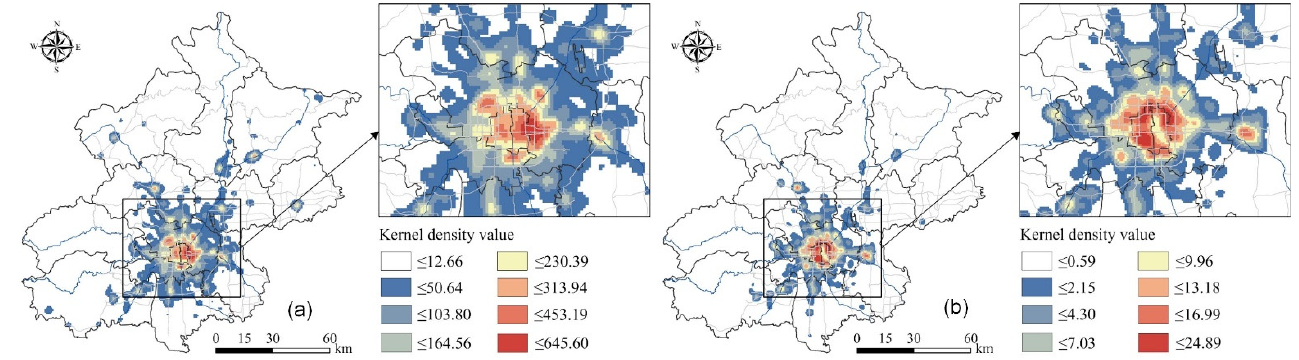
Figure 5. Estimated kernel density of commercial and residential spaces in Beijing: ( a ) the overall commercial spaces, and ( b ) the overall residential spaces.